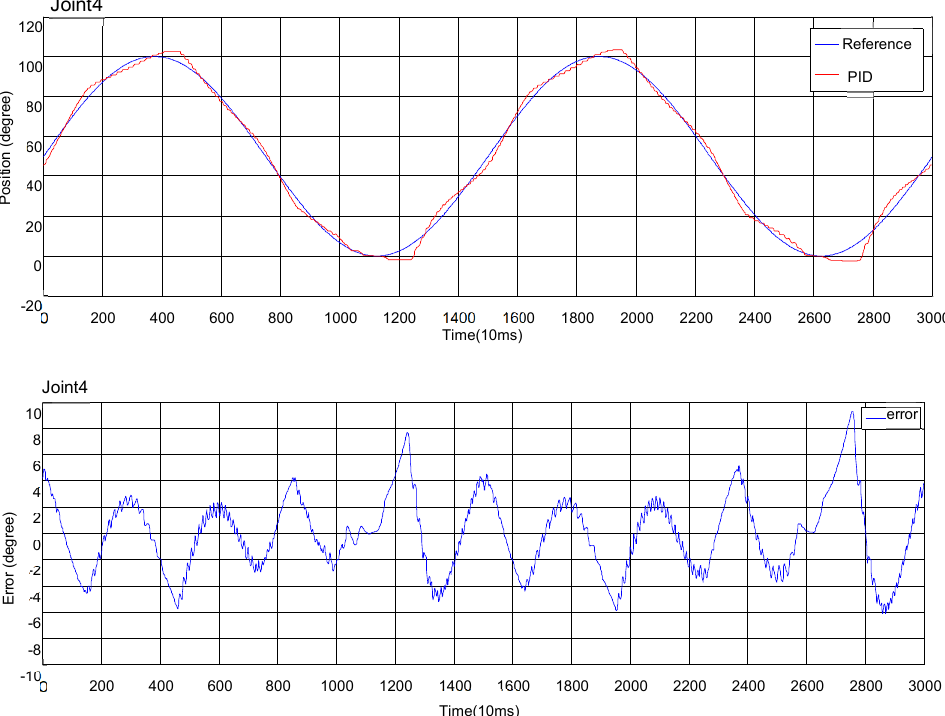
Figure 10. Dual PAM pressure output of PID simulation parameters applied to real system. Table 4. Comparison table of PID controllers for actual and simulated systems. Actual System